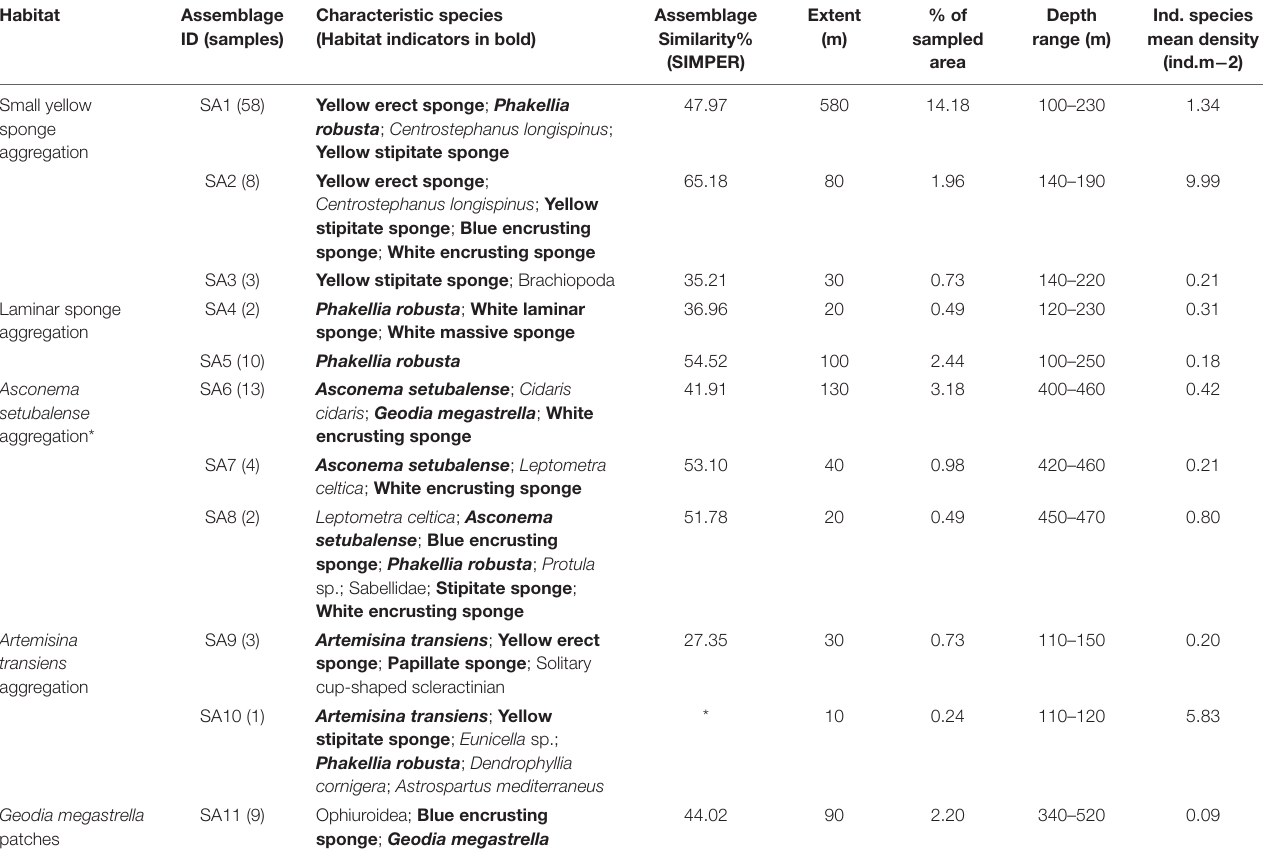
TABLE 2 | Assemblages characterized and dominated by sponges in the São Vicente Submarine Canyon. Habitat Assemblage